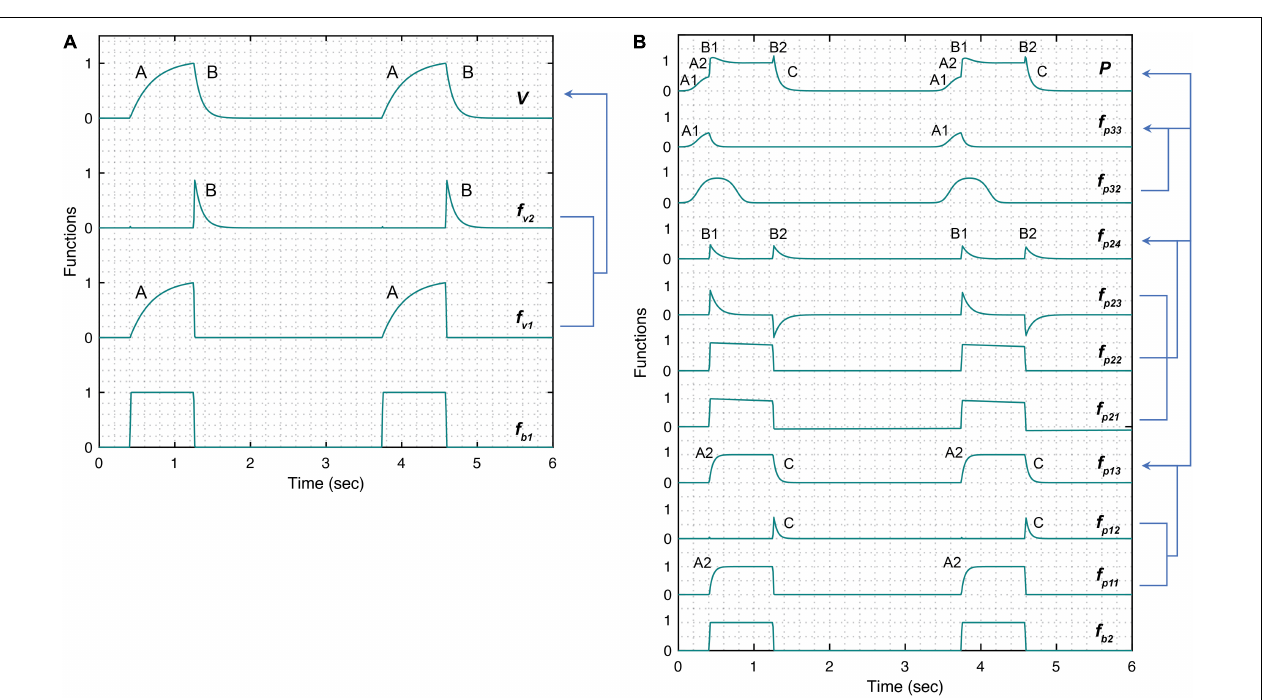
FIGURE 2 | Simulated response of various terms that make up the damage-informed volume ( V ) and pressure model ( P ). (A) A periodic rectangular waveform f b 1 is used to create terms f v 1 and f v 2 through which the gradient of the rising (feature A) and falling (feature B) signals in the volume waveform are controlled, respectively. Equations 1–5 were used to simulate the response within each term with parameter values θ = 0.3, a 1 = 200, b 1 = 0.7, φ 1 = 0, β 1 = 30, β 2 = 10, and A v = 1. (B) A periodic rectangular waveform ( f b 2 ) serves as a basis of the pressure model. The overall shape of the pressure waveform, which defines the gradient of the inspiration and expiration signals, is formed using f p 13 comprised of the rising signal of f p 11 (A2) and falling signal of f p 12 (C). The shape of the plateau pressure is defined by f p 24 , where the output of f b 2 is processed via f p 21 , f p 22 , and f p 23 to produce peaks at the beginning (B1) and end (B2) of the plateau pressure. The shape of the rising signal at low volume (A1) is defined by f p 33 , where a short pulse is produced via f p 31 and reshaped via f p 32 . Note that the amplitude terms A p 1 , A p 2 , and A p 3 control the amplitude of f p 13 , f p 24 , and f p 33 , respectively. Equations 6–18 were used to simulate the response of each term with parameter values θ = 0.3, a 2 = 200, b 2 = 0.7, φ 2 = 0, a 3 = 10, b 3 = 0.9, φ 3 = –0.6, β 3 = β 4 = 5, β 5 = 1.001, β 6 = 1.1111, A p 1 = 1, A p 2 = 0.5, A p 3 = 0.5, and A p 4 = 0. Note that the model variability shown here is independent of the ventilator